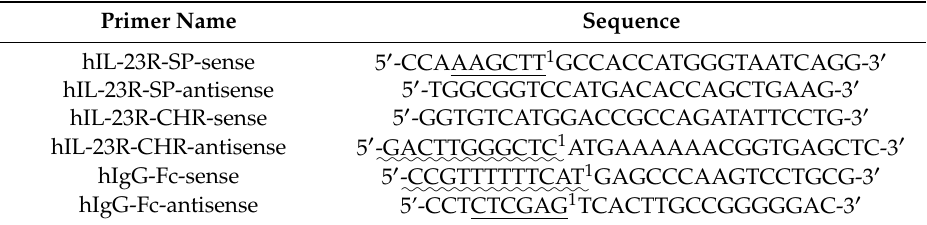
Table 1. Primer sequences for over-lap PCR.